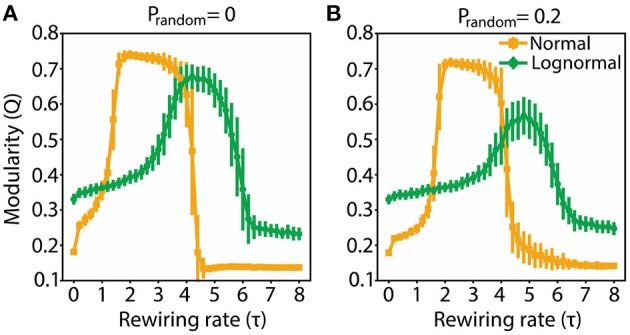
Modularity for both normal and lognormal networks grows as τ increases, but then decreases for larger τ values. (A) Q as a function of τ for prandom = 0. (B) Same as (A) for prandom = 0.2. Vertical lines indicate standard deviations from 100 instantiations of the rewiring algorithm.